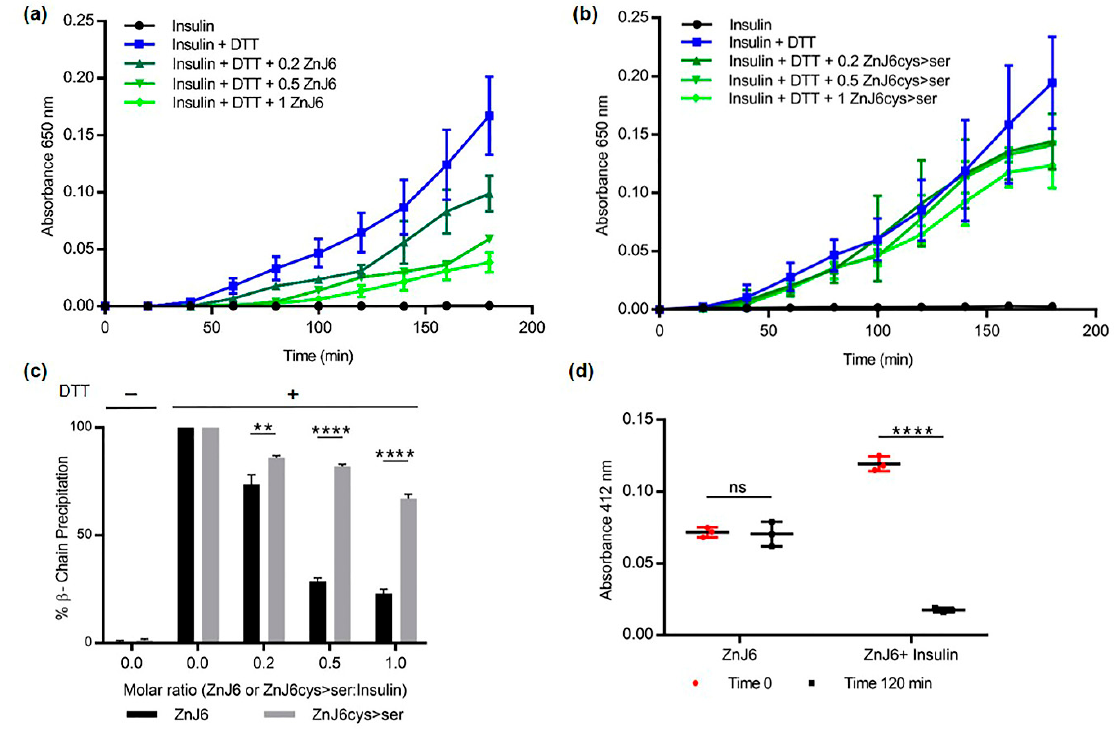
Figure 5. The C4-type zinc finger domain (ZF) is required to prevent aggregation of the reduced insulin chain. The insulin turbidity assay was used to examine the thiol-dependent activity of ZnJ6. Increasing molar ratios of ZnJ6 relative to insulin were added (0:1, 0.2:1, 0.5:1, 1:1), and precipitation of the insulin β -chain was measured at 650 nm for 3 h at 25 °C. A reaction containing insulin alone served as a control. ( a ) Precipitation was monitored in the presence of WT recombinant ZnJ6 and ( b ) ZnJ6cys > Ser-mutant. ( c ) Summary of end-point precipitation values obtained in the presence of different molar ratios of the ZnJ6 (black columns) and the ZnJ6cys > Ser-mutant (gray columns) after 3 h. ( d ) Protein-bound sulfhydryl (-SH) groups were calculated using the Ellman’s test before (red circles), and after incubation of ZnJ6 (black squares), with or without insulin, that was introduced at an equal molar ratio. Presented values are mean of triplicates, the Student’s t -test was used for statistical analysis, and the error bars are standard deviation (****: p value ≤ 0.0001, **: p value ≤ 0.01, ns: not significant). The results indicate that ZnJ6 significantly prevents the aggregation of Insulin chains as compared to the ZnJ6cys > Ser-mutant.